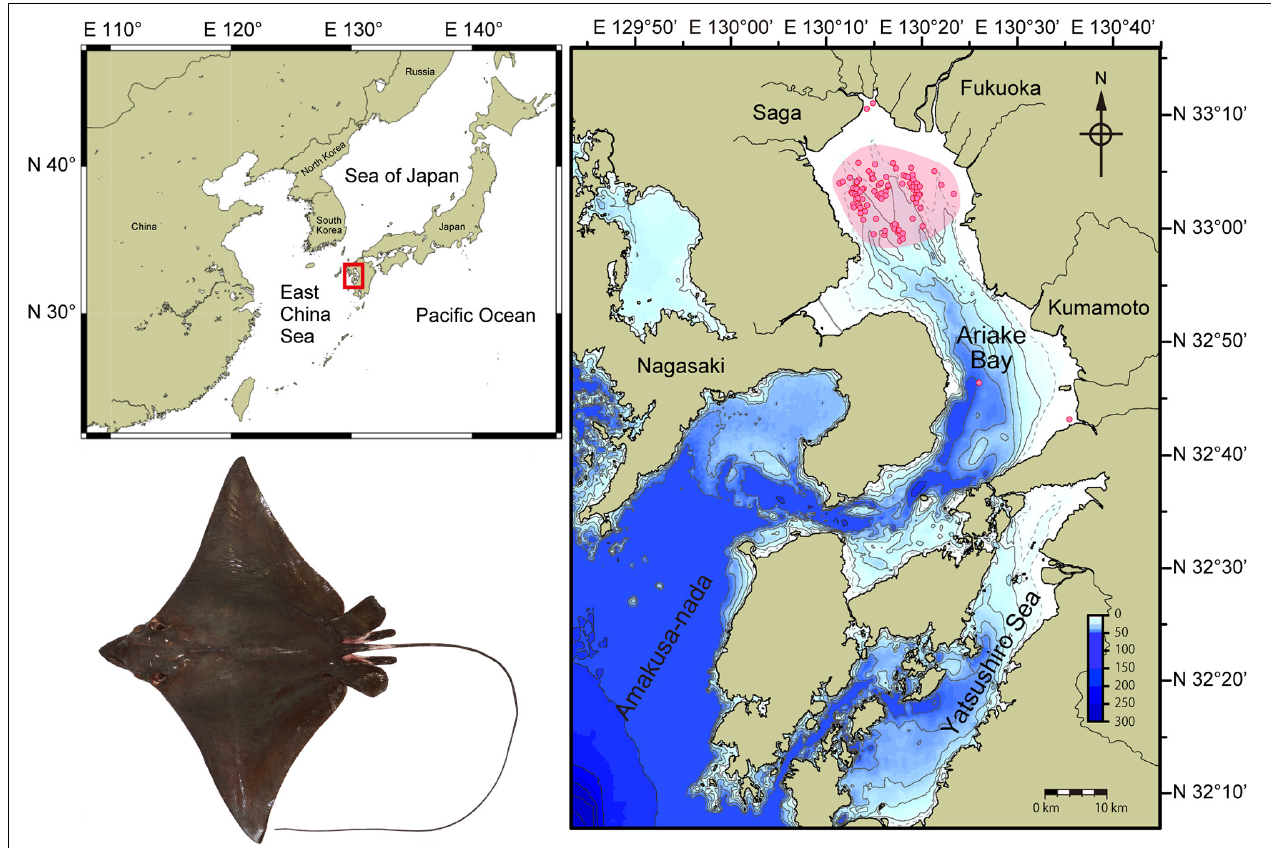
FIGURE 1 | Ariake Bay (red rectangle) is on the western coastline of Japan and open to the East China Sea. Aetobatus narutobiei sampling areas within Ariake Bay are shown in detail (inset) with pink shading representing regions used by commercial vessels or as part of the predator control program and predominantly using gill nets. Red circles indicate specific sampling sites of vessels that contributed specimens for the study. Few rays were sampled from the river delta regions and rays were not sampled from deeper regions of the bay except during the migration